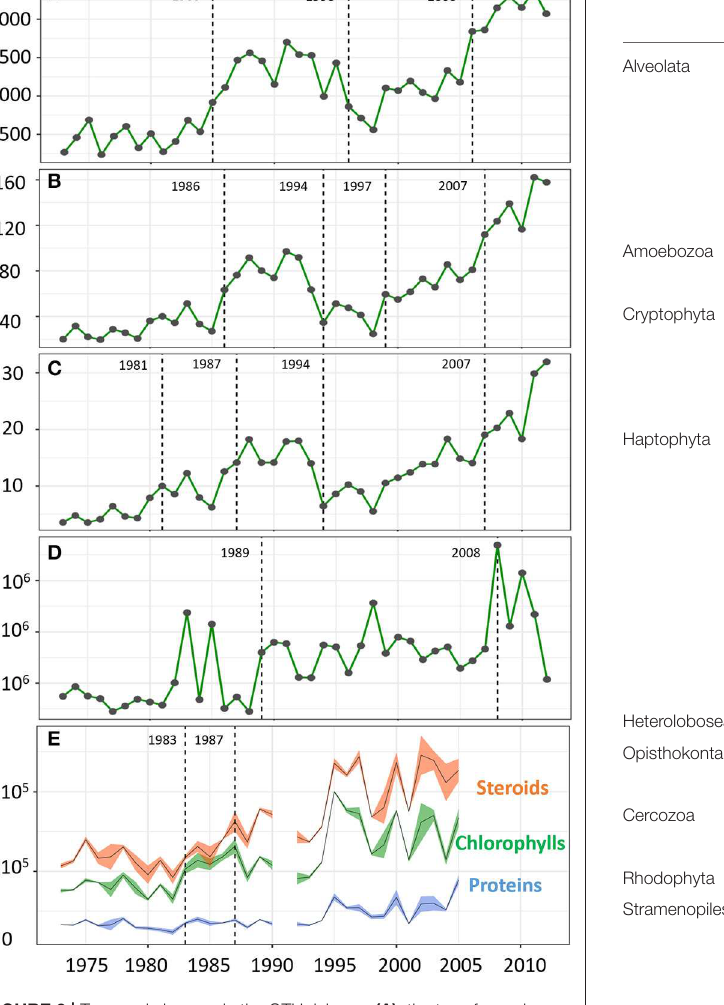
TABLE 1 | Number of DNA sequences and OTUs within taxonomic groups of the protistan community.